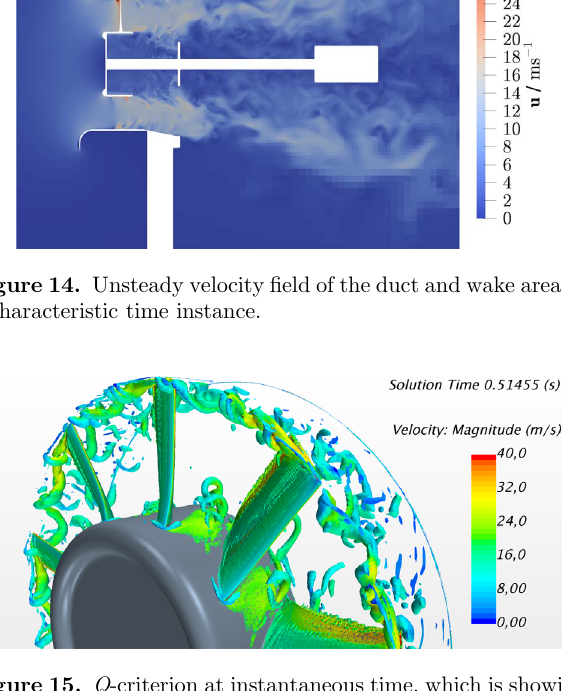
Figure 15. Q -criterion at instantaneous time, which is showing the turbulent structures of the tip fl ow.